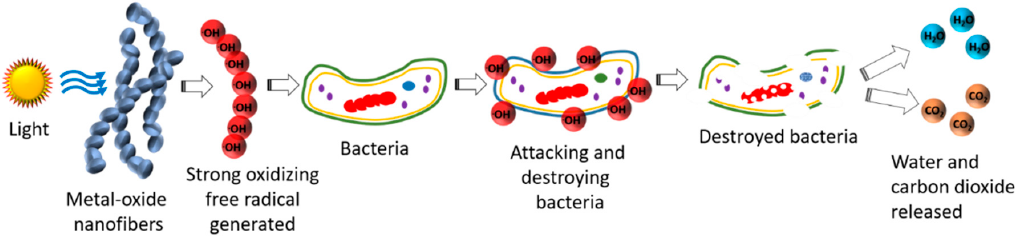
Figure 13. An illustration explaining bacterial disinfection mechanism by nanofiber photocatalyst under light illumination.